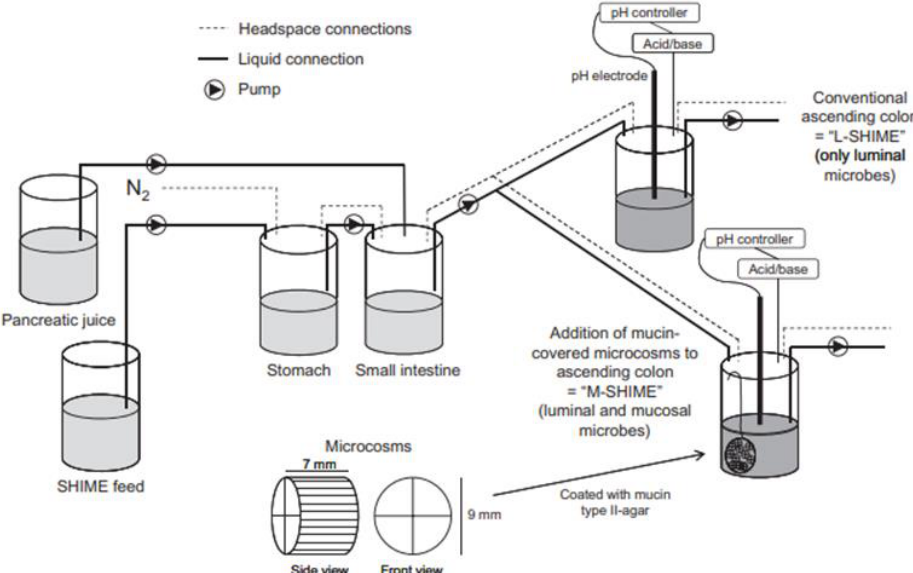
Figure 12. Schematic overview of the implementation of a new second unit modified by incorporating a mucosal compartment (=mucosal SHIME or M-SHIME), which contained 100 mucin-covered microcosms per 500 mL suspension. The general experimental design is composed of several double-jacketed vessels, simulating the stomach, small intestine and three main colonic regions. In this experiment, only the first colon compartment (ascending colon) was used and inoculated with a human fecal microbiome. The first ascending colon unit consisted of the conventional set-up that only harbors luminal microbes (=luminal SHIME or L-SHIME), whereas the second unit is the M-SHIME. Adopted with permission from [226], John Wiley & Sons, 2011.